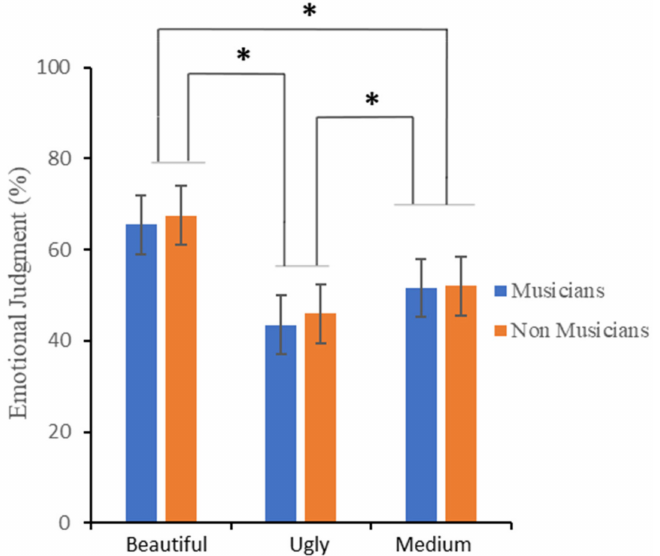
Figure 4. Participants’ mean rating percentage scores for the emotional evaluation. Error bars represent ± 1 SEM. Asterisks represent significant